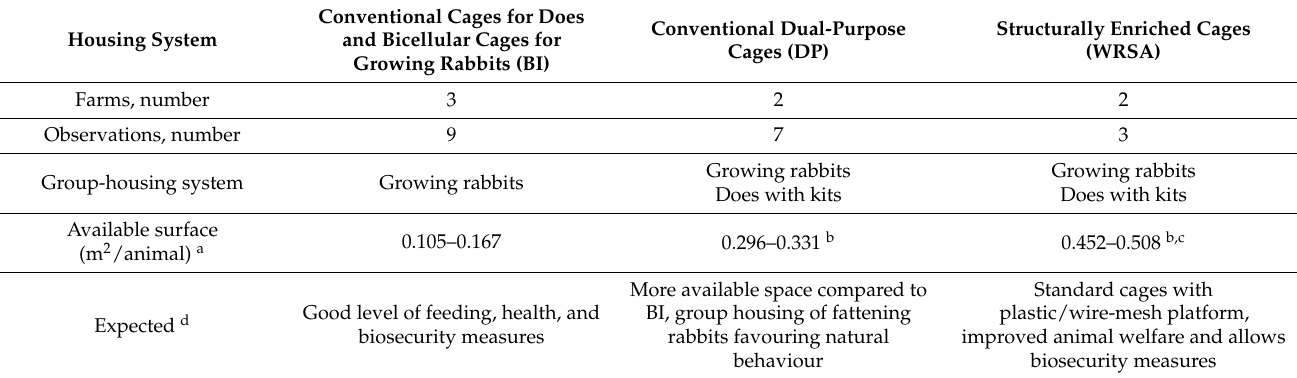
Table 1. Characteristics of the housing systems present in the farms surveyed in this study. Housing